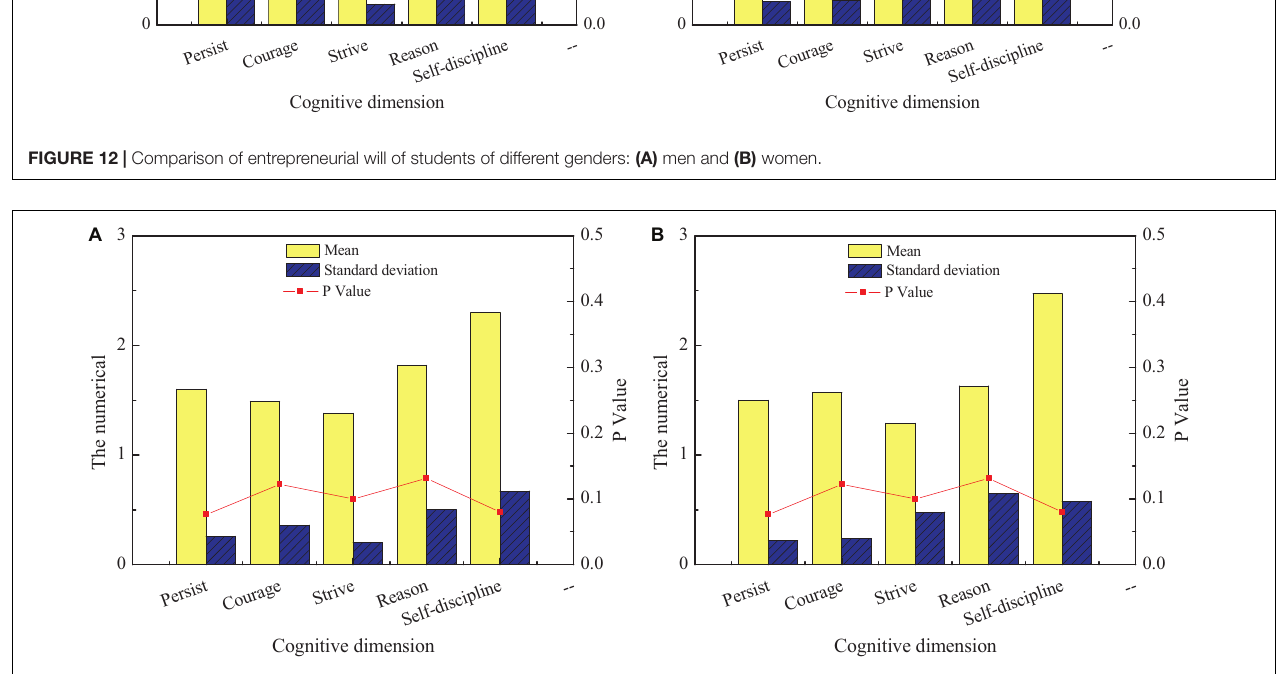
FIGURE 13 | Comparison of entrepreneurial will among students of different disciplines: (A) liberal arts and (B) science.